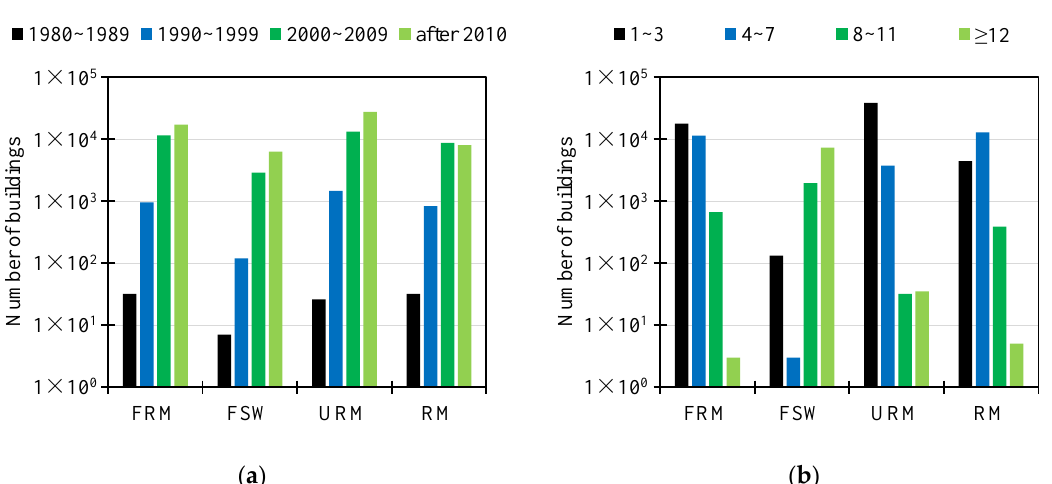
Figure 4. Basic details of the case-study buildings. ( a ) Distribution of construction year; ( b ) distribution of number of stories.